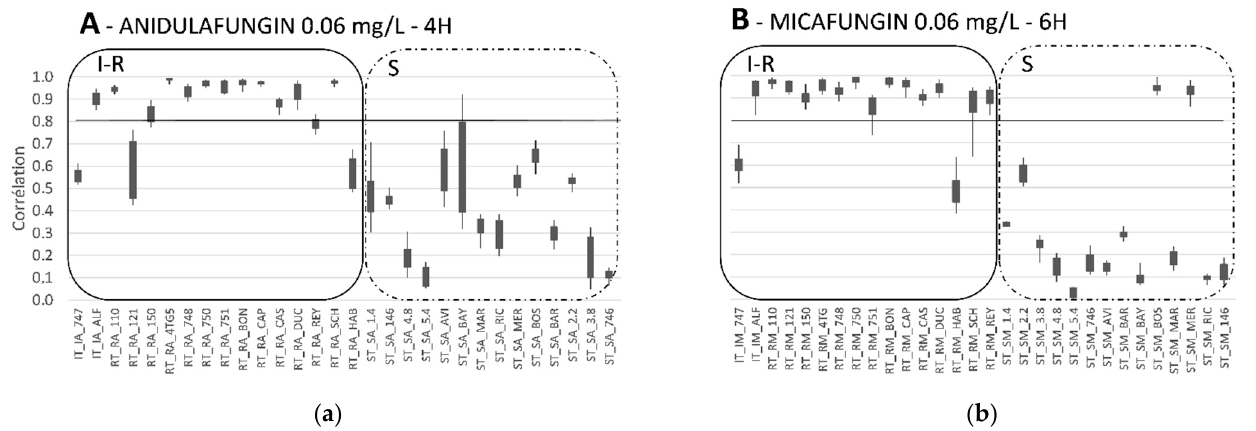
Figure 1. Antifungal susceptibility testing with MALDI-TOF MS: example with echinocandin resistant Candida glabrata strains. ( a ) Panel A: Strains were incubated 4 h with 0.06 mg/L of anidulafungin. ( b ) Panel B: Strains were incubated 6 h with 0.06 mg/L of micafungin. S ‐ I ‐ R ‐ S: sensitive ‐ intermediate or resistant strains according to the EUCAST clinical breakpoints (https://eucast.org/astoffungi/clinicalbreakpointsforantifungals/ accessed on 3 May 2021). Each strain was tested in three different experiments, in triplicates.